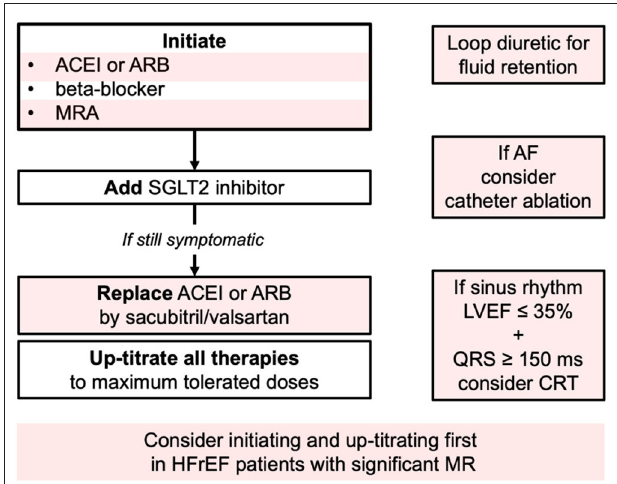
FIGURE 3 | Current guideline directed approach (Class I indications 2021 ESC guidelines). HFrEF, Heart failure with reduced Ejection fraction; ACEI, angiotensin-converting enzyme inhibitor; ARB, angiotensin receptor blocker; MRA, mineralocorticoid receptor antagonist; SGLT2, sodium-glucose cotransporter 2; AF, atrial fibrillation; LVEF, left ventricle ejection fraction; CRT, cardiac resynchronization therapy; MR, mitral regurgitation.